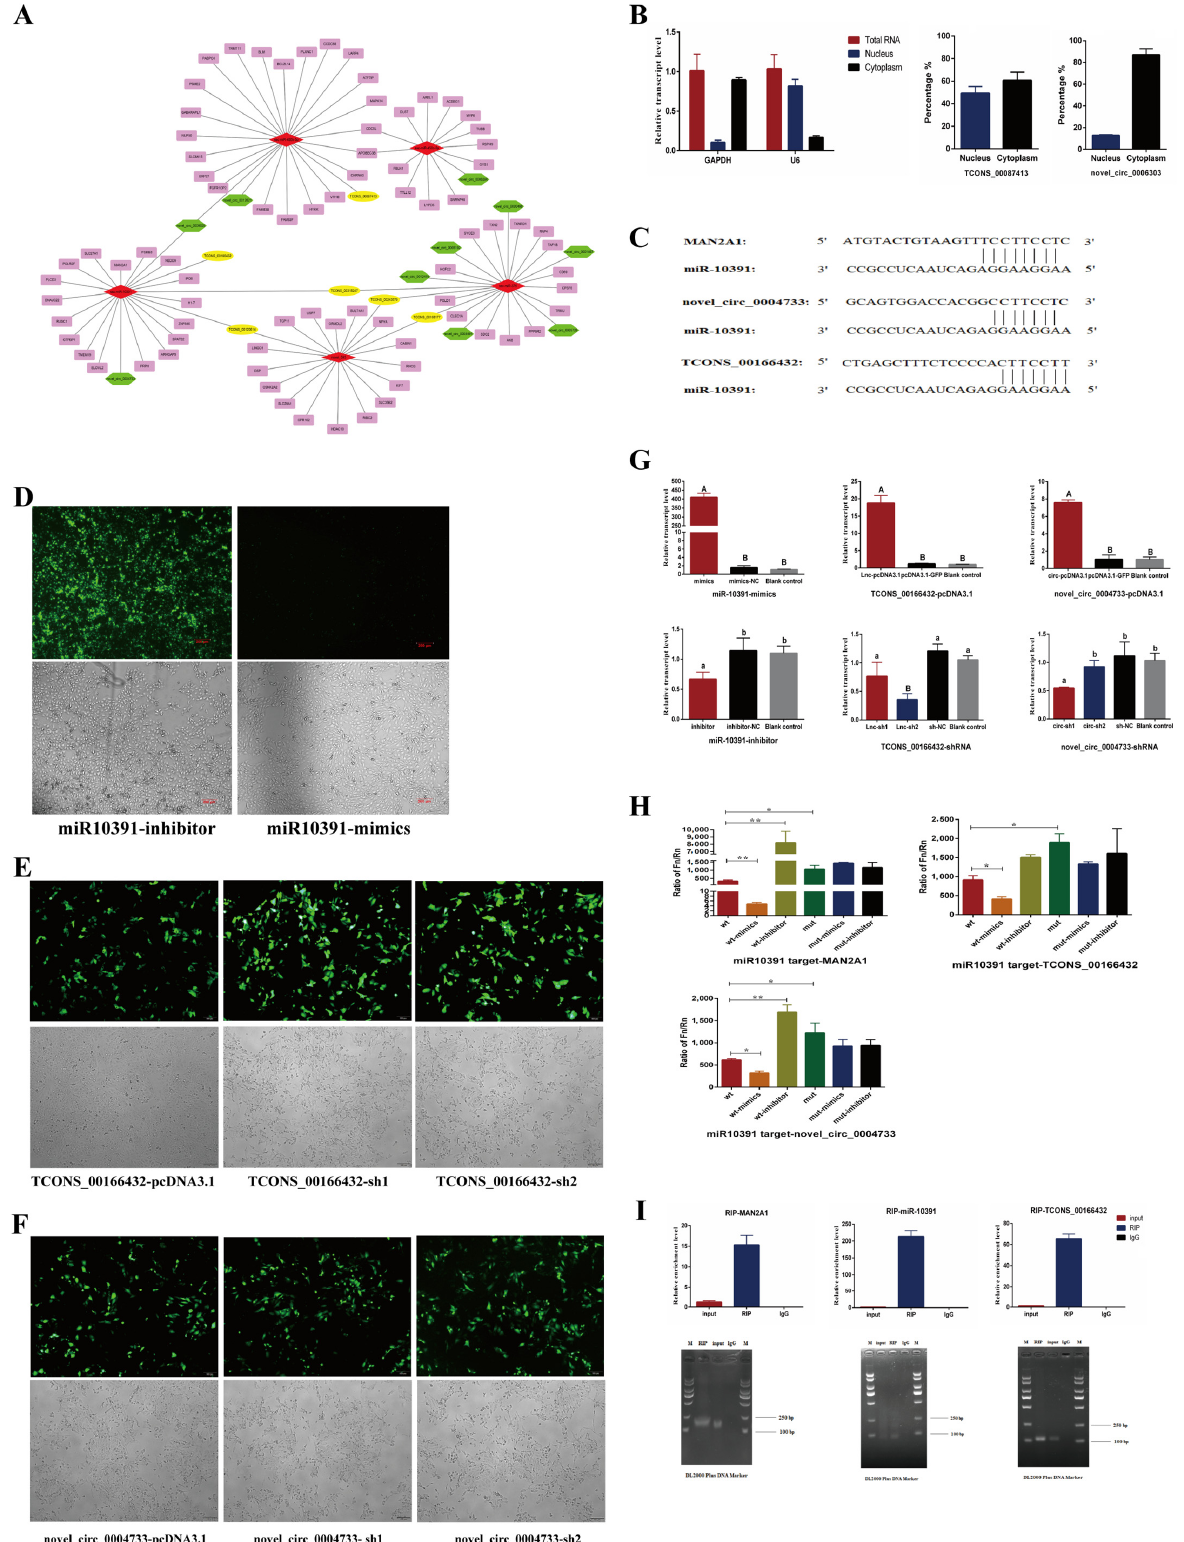
Figure 3. Verification of ceRNA networks in 3D4/21 cells infected by H1N1 and H3N2. ( A ) represents the predicted ceRNA networks diagram. The red diamond represents miRNA, the yellow ellipse represents lncRNA, the green hexagon represents circRNA, and the pink rectangle represents